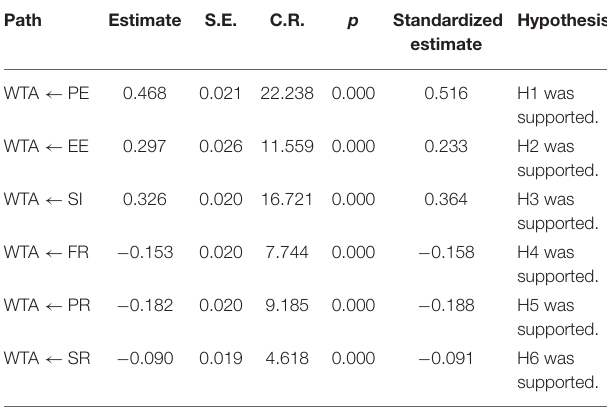
TABLE 5 | Path analysis results of the model influencing